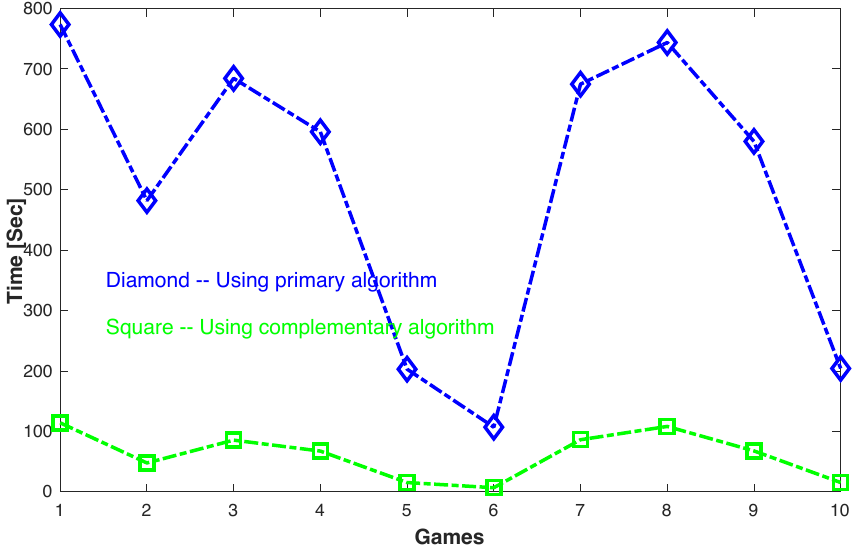
Figure 2. Performance Results: The computing times for obtaining the densest equilibrium strategies for 10 randomly generated games using the complementary vs. primary Shapley-Snow